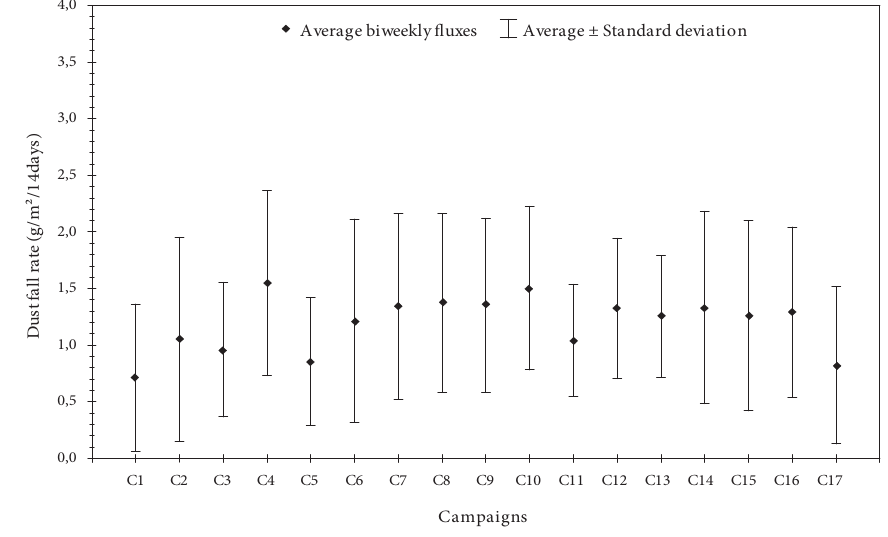
Figure 3. Temporal variations of biweekly dust fall rate